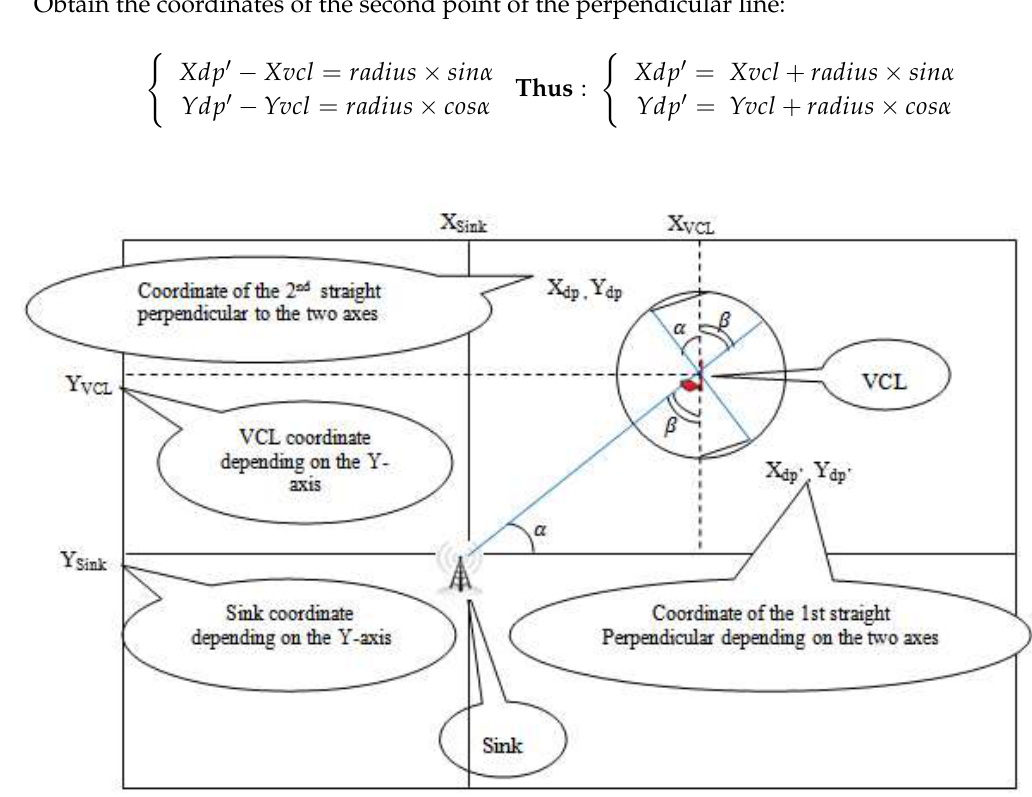
Figure 1. Linking the sink with the VCL sensor.